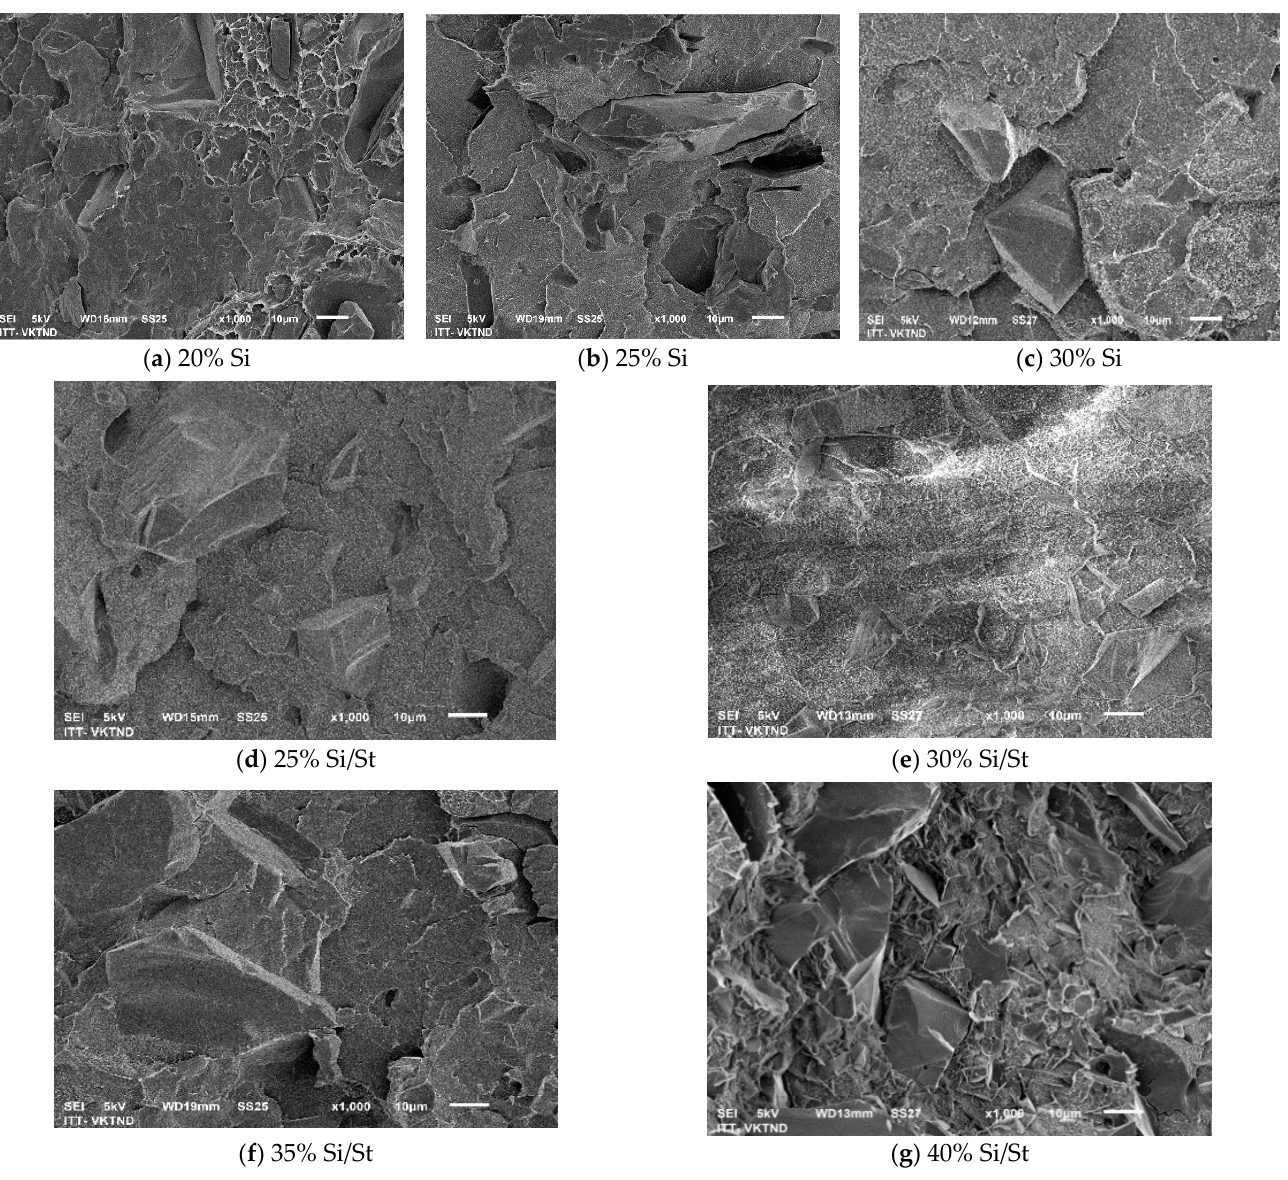
Figure 2. The morphology of the fracture surface of untreated and treated bentonite/PE masterbatches.